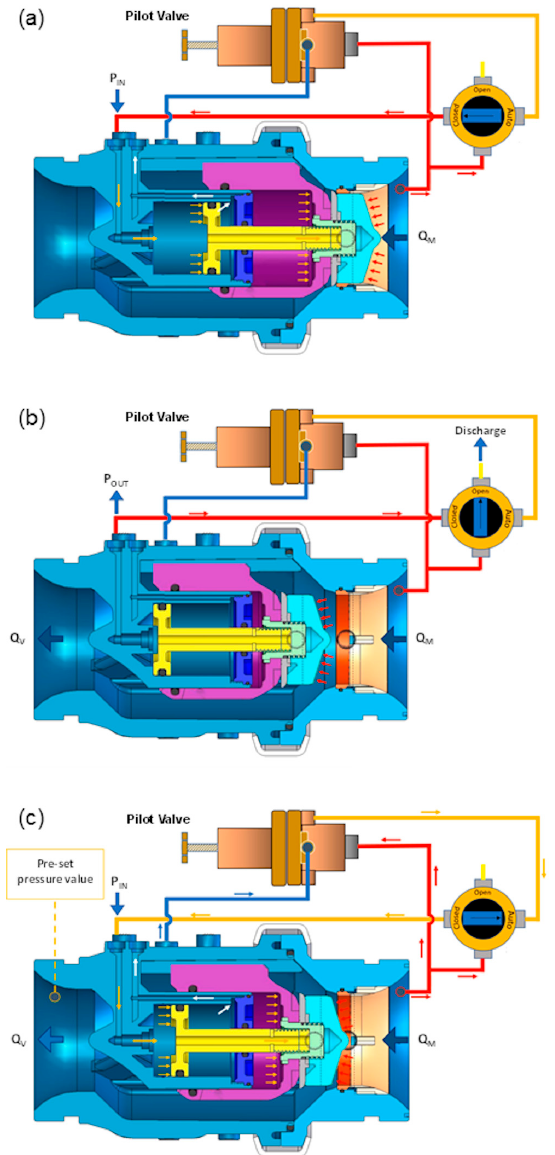
Figure 2. Scheme of the PA-PRV showing the inner structure of the device and the adjustment mechanism in case of ( a ) complete closure, ( b ) complete opening and ( c ) modulating functioning .